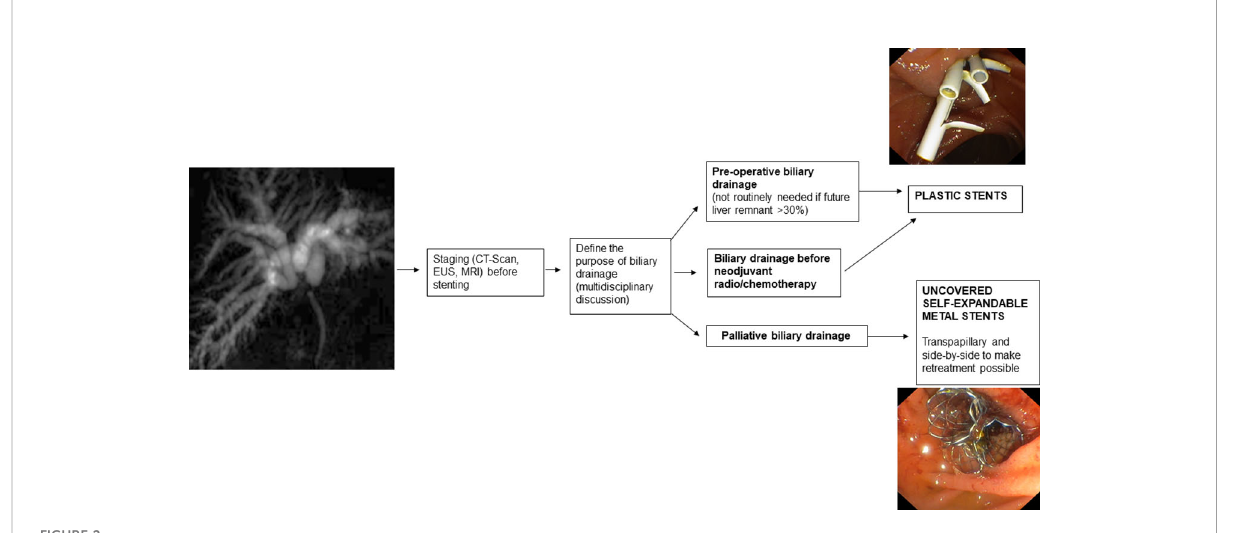
FIGURE 2 Malignant Hilar Strictures and choice of the stent.